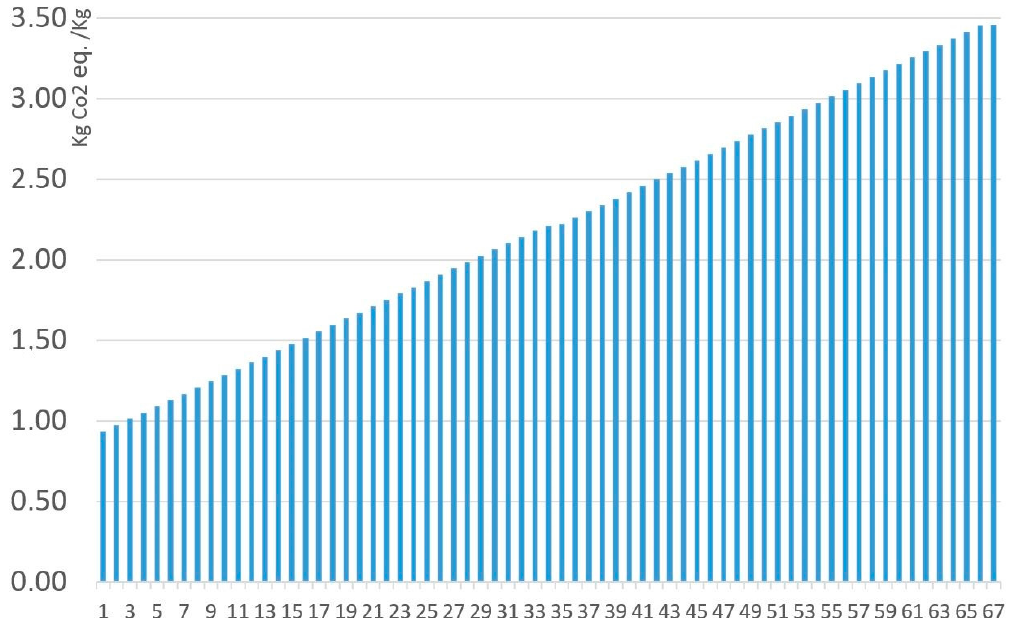
Figure 11. Environmental impact (RMA + Production) of 1 kg NiZn for the 67 ferrites, under the Carbon Footprint methodology.